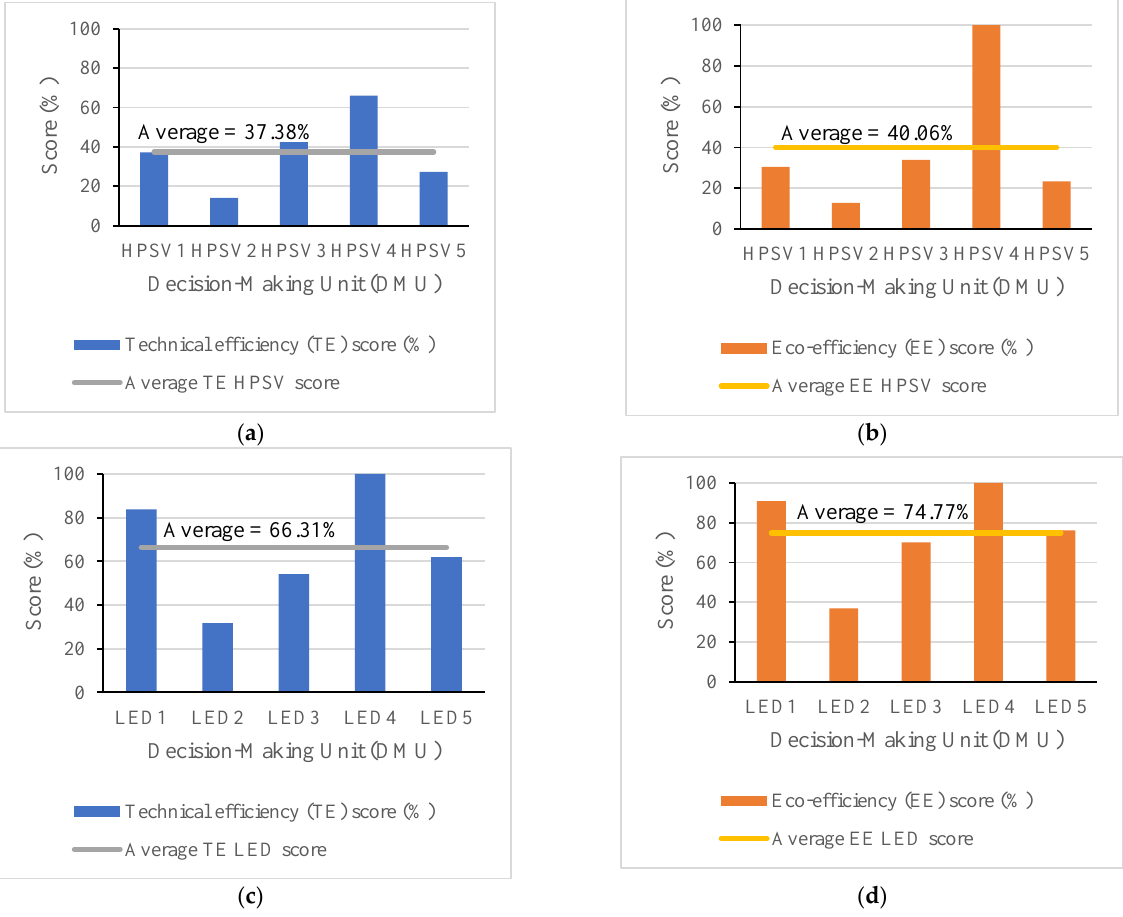
Figure 3. Comparative efficiency scores between CCR and DDF approach for HPSV and LED Road Lighting: ( a ) technical efficiency for HPSV Road Lighting Technology; ( b ) eco-efficiency for HPSV Road Lighting Technology; ( c ) technical efficiency for LED Road Lighting Technology; ( d ) eco-efficiency for LED Road Lighting Technology.